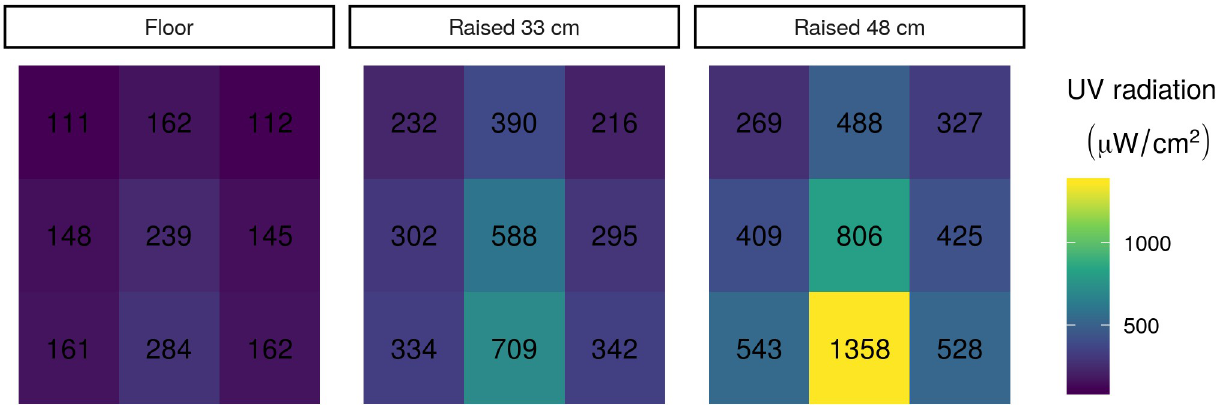
Fig 2. UV radiation in each sector of BSC 1 at three different heights. Each of the nine sections per elevation shows the UV radiation measured in the section. Numbers indicate UV radiation measured in each location with the UV meter.